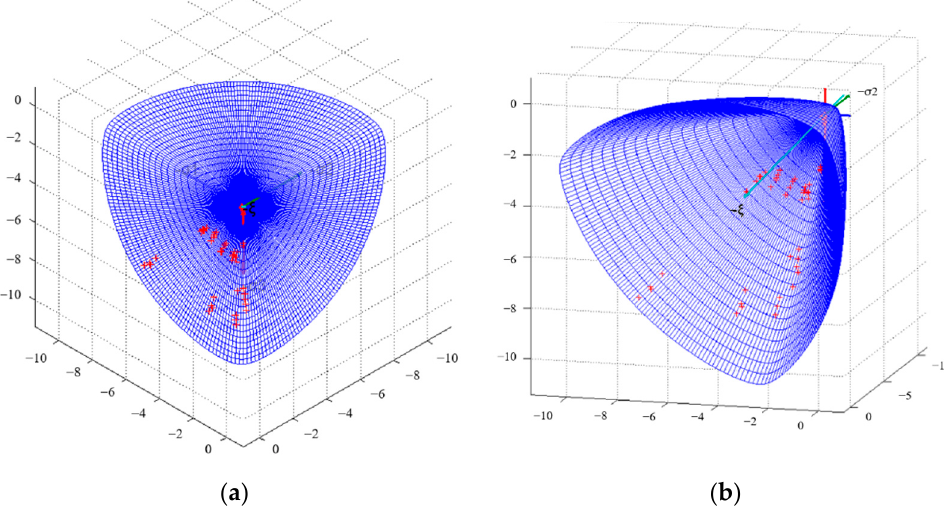
Figure 21. The experimental fitting on the failure surface in the principal stress space: ( a ) overhead view and ( b ) side view.